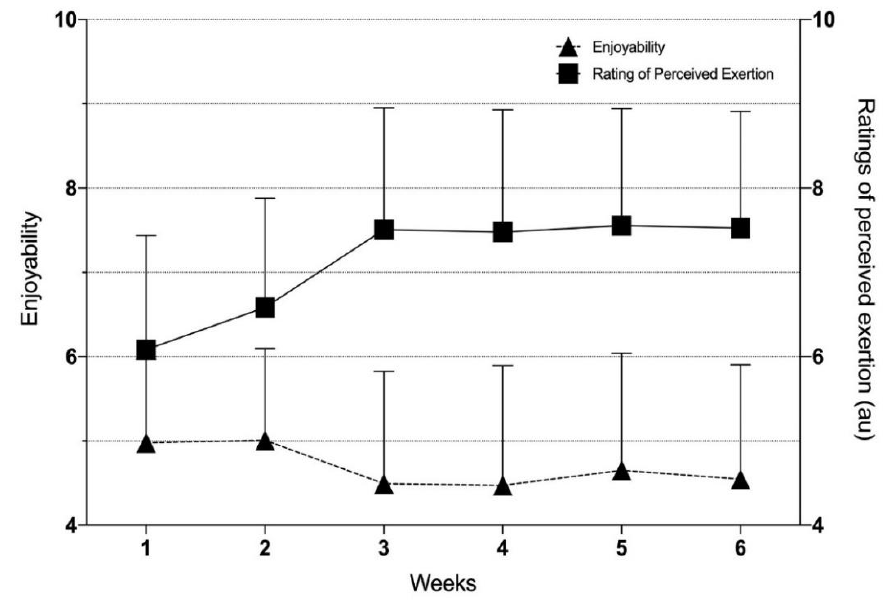
Figure 7. Weekly training levels of enjoyability and ratings of perceived exertion or RPE at the end of the exercise sessions across the 6 weeks of training of participants in the intervention or training group (INT, N = 16). The mean data is the average of all sessions performed over that week.